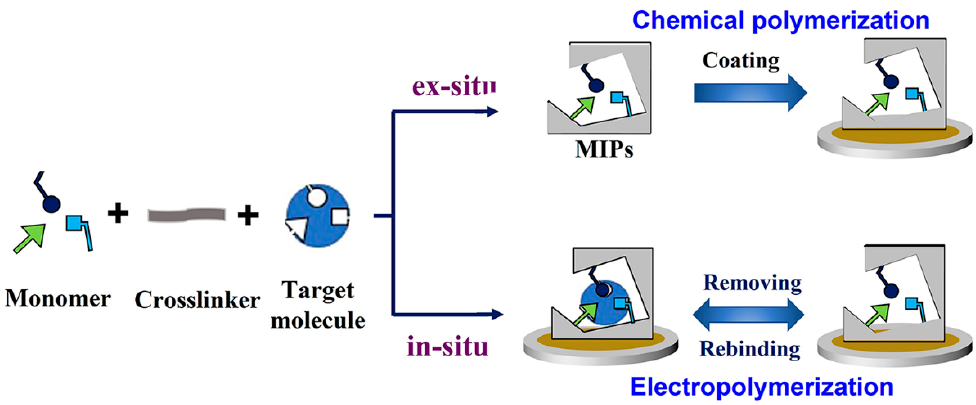
Figure 3. Schematic view of the construction of MECs through an ex-situ/in-situ